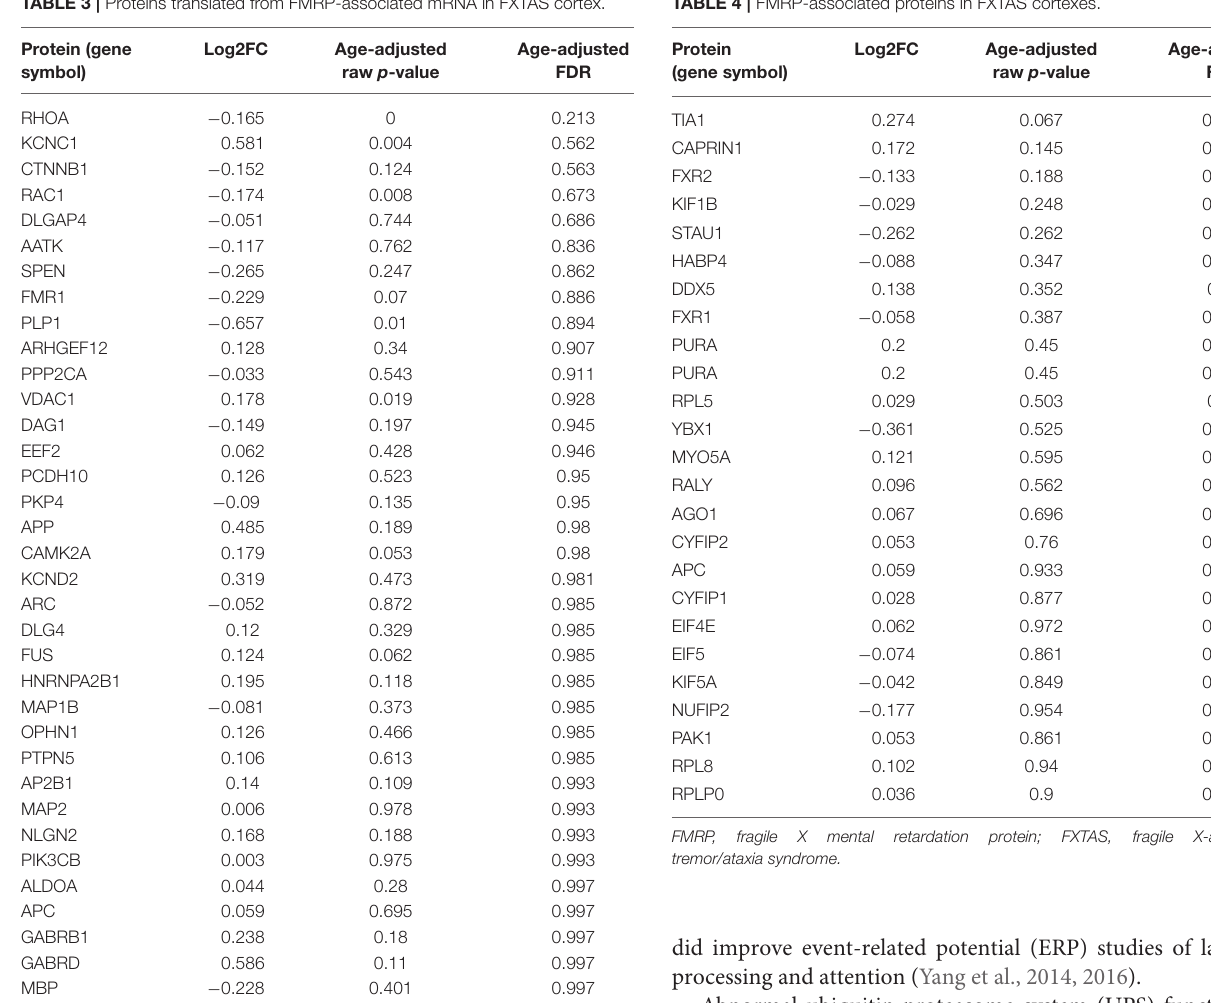
TABLE 4 | FMRP-associated proteins in FXTAS